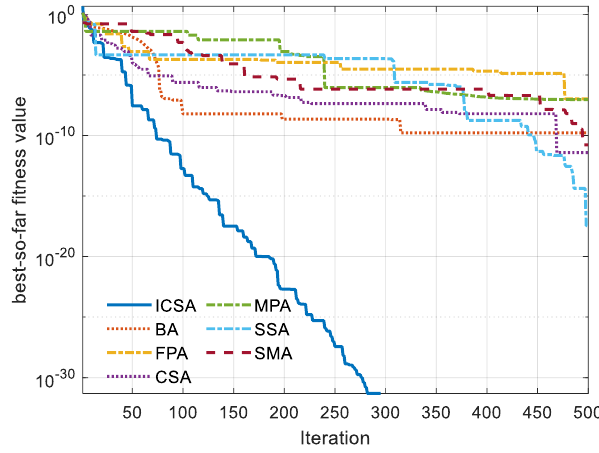
Figure 21. Convergence curve for F21.